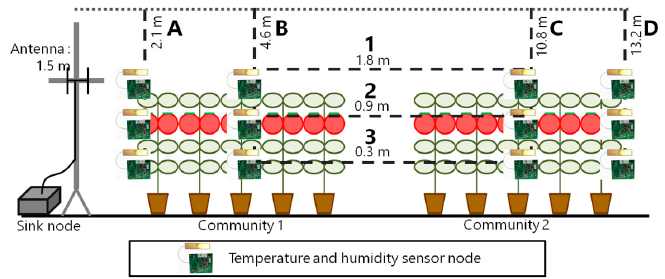
Figure 7. Sensor position for the basic experiment.